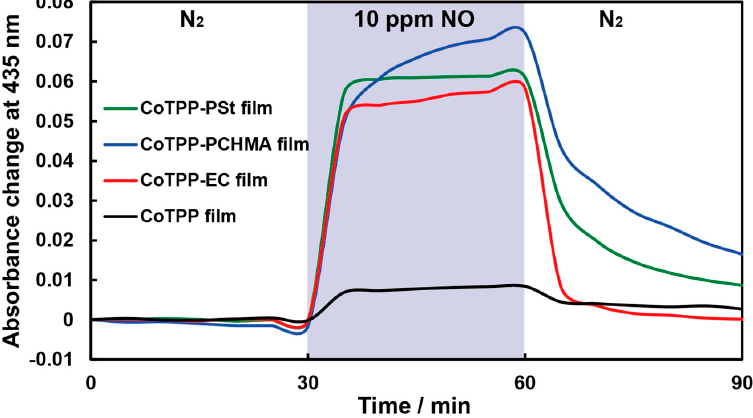
Figure 4. Typical responses of CoTPP film (black), CoTPP-EC film (red), CoTPP-PCHMA film (green), and CoTPP-PSt film to 10 ppm of NO/N 2 at 100 °C. The blue zone indicates the period of NO gas introduction.